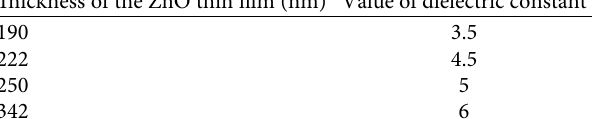
Table 1: Variation of the dielectric constant of ZnO thin films with the variation of film thickness at a fixed wavelength of 600nm [118].